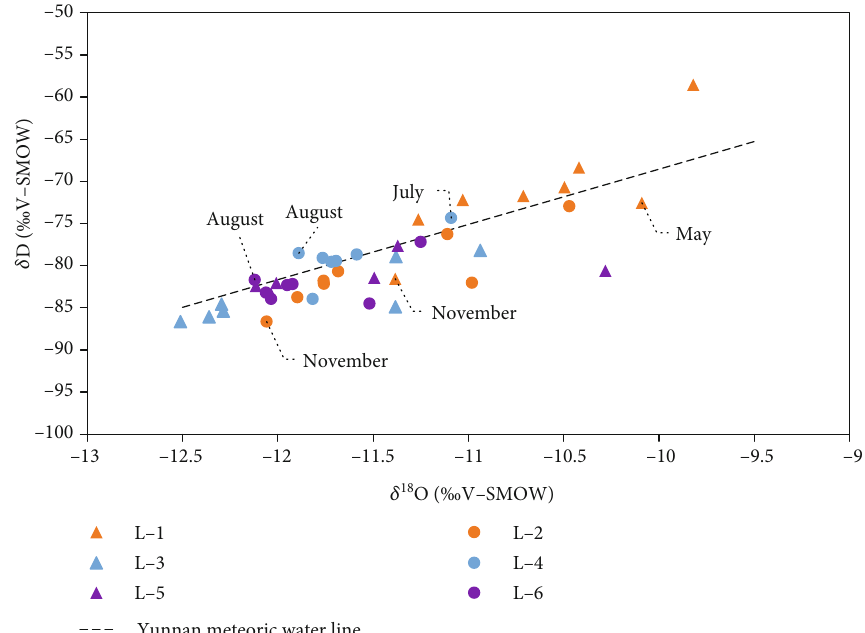
Figure 4: Relationship between δ D and δ 18 O isotopes in produced water.